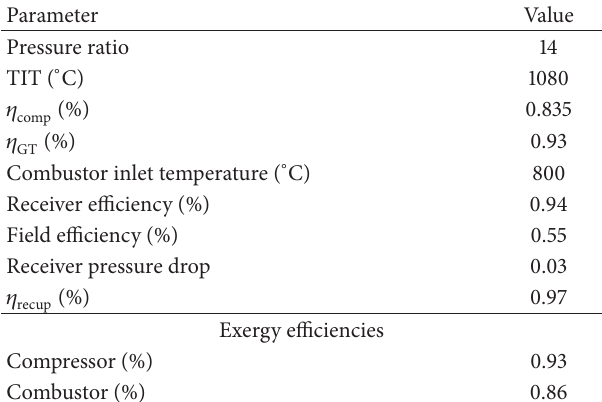
Table 2: Performance parameters of GT-solar cycle.